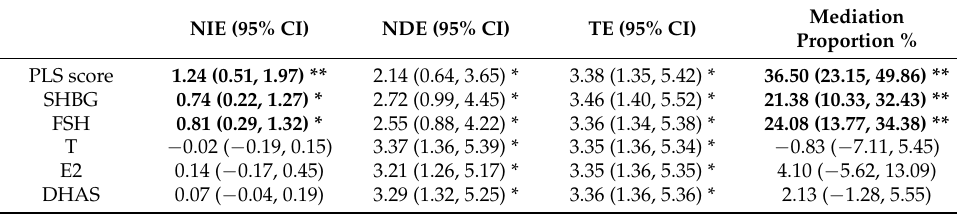
Table 2. The Mediation effect of PLS score and each sex hormone on association between over- weight/obesity and hyperglycemia by excess relative risk (ERR)